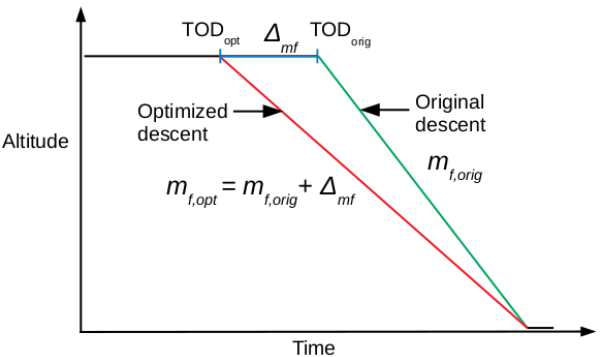
Figure 4. Optimization of descent trajectory with increased fuel